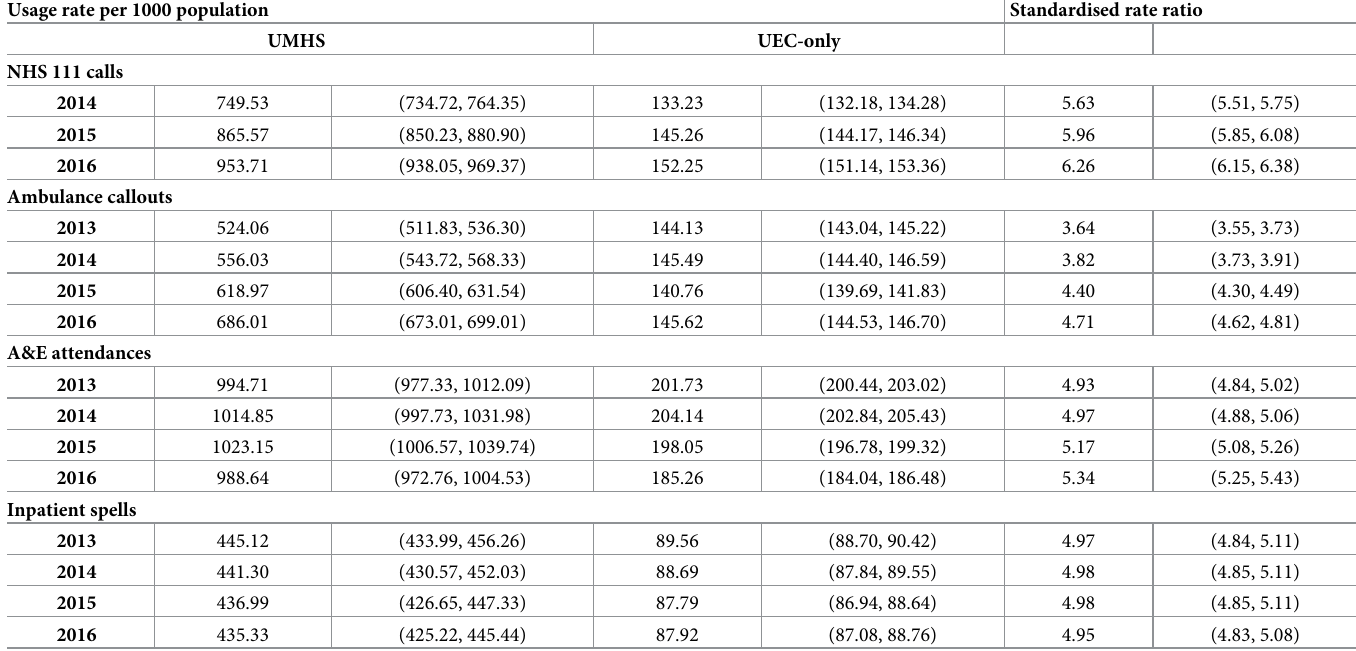
Table 2. Age & sex standardised usage rates (95% confidence intervals) per 1000 population for each UEC service by study year, and comparison as standardised rate ratio (SRR).